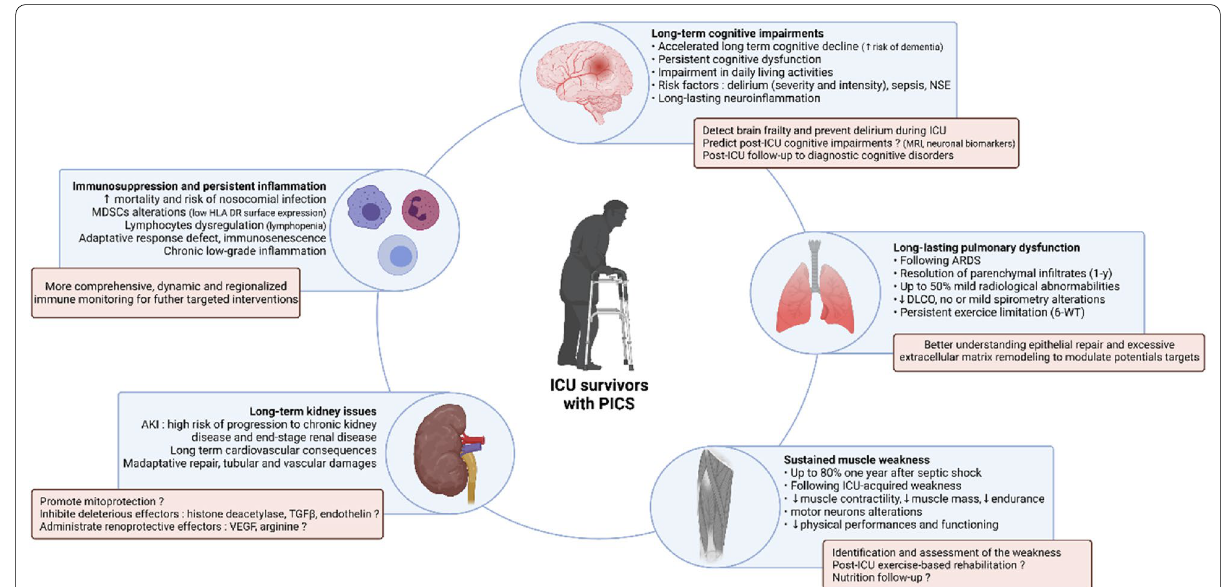
Fig. 1 ICU survivors with post‑intensive care syndrome. Clinical characteristics and consequences, and futures research directions for each long‑lasting sub‑syndrome after ICU